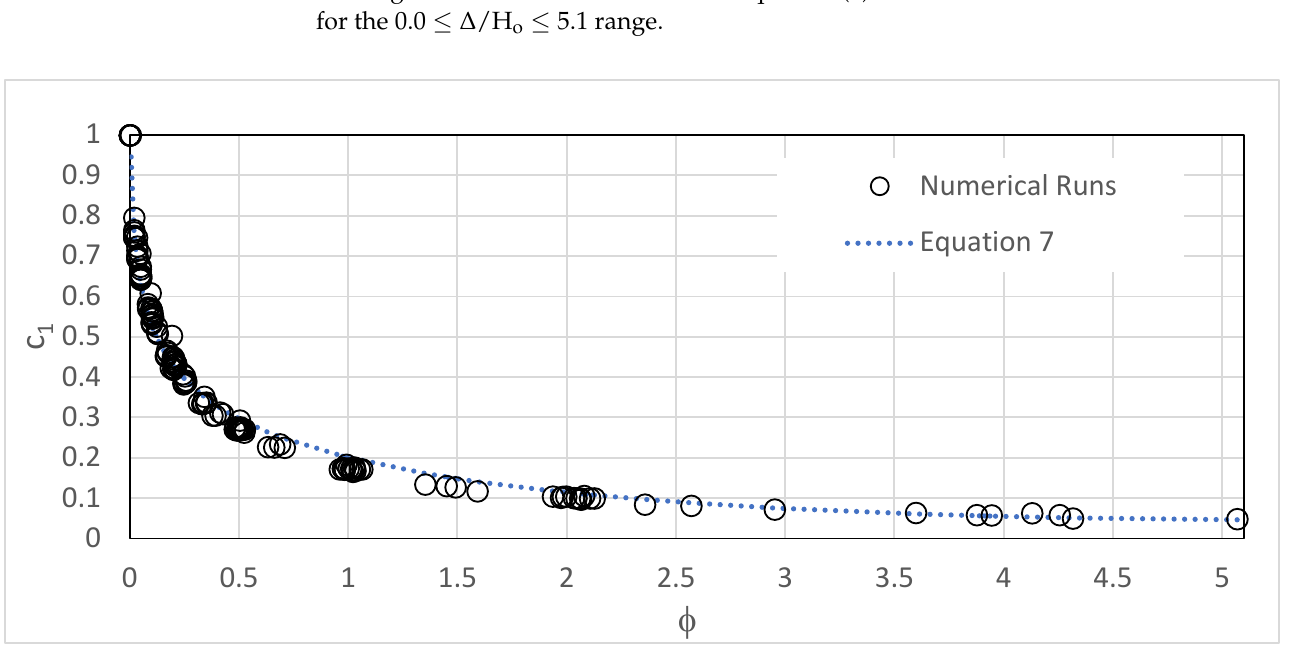
Figure 6. Coefficient c1 as a function of φ (for ∆/Ho ≤ 5.1).